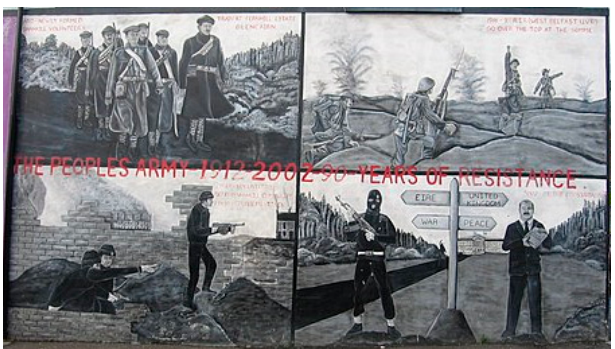
Figure 2. Belfast Unionist Mural (2010).This UVF mural includes a depiction of the charge at the Somme in the top right panel. The red lettering in the center reads “The Peoples [sic] Army 1912–2002 — 90 Years of Resistance.” Used under the Creative Commons liscense.